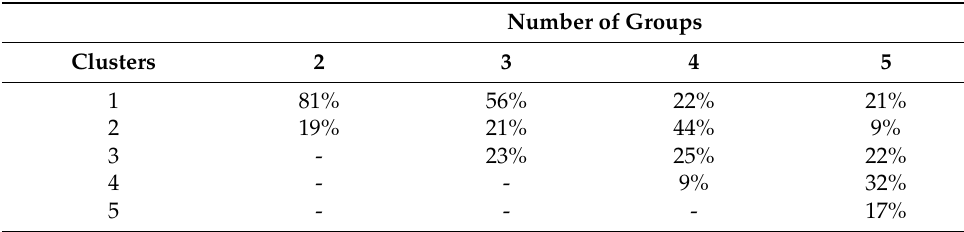
Table 5. Percentage of sample within each